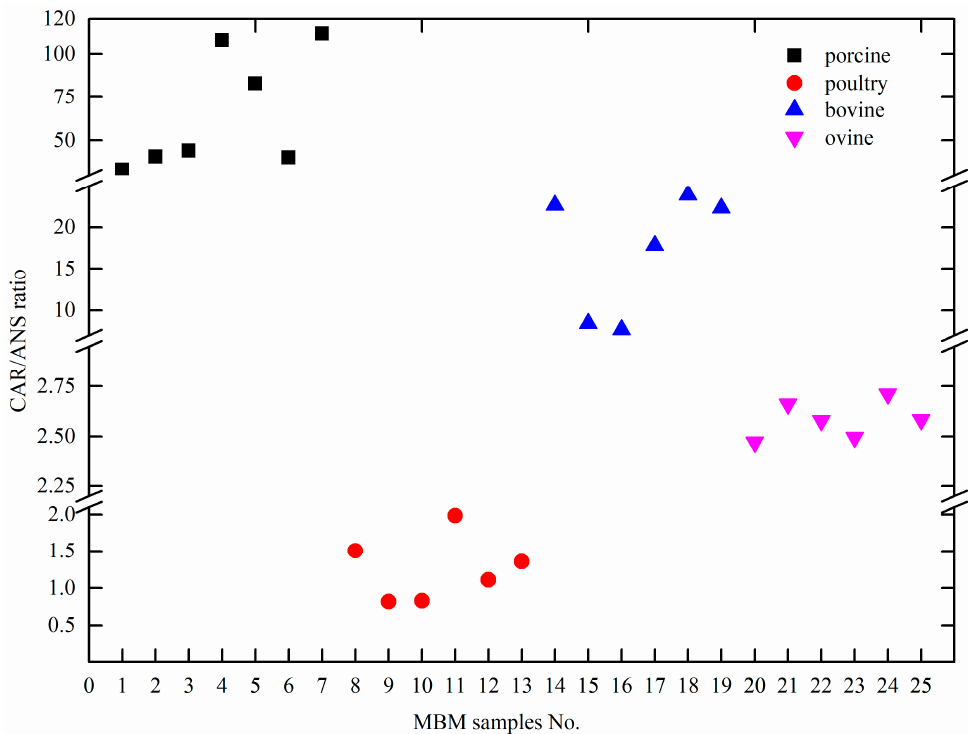
Figure 4. The carnosine amounts/anserine amounts (CAR/ANS) ratio in four types of MBM samples (porcine (No.1–No.7), poultry (No. 8–No. 13), bovine (No. 14–No. 19), and ovine origins (No. 20–No. 25))